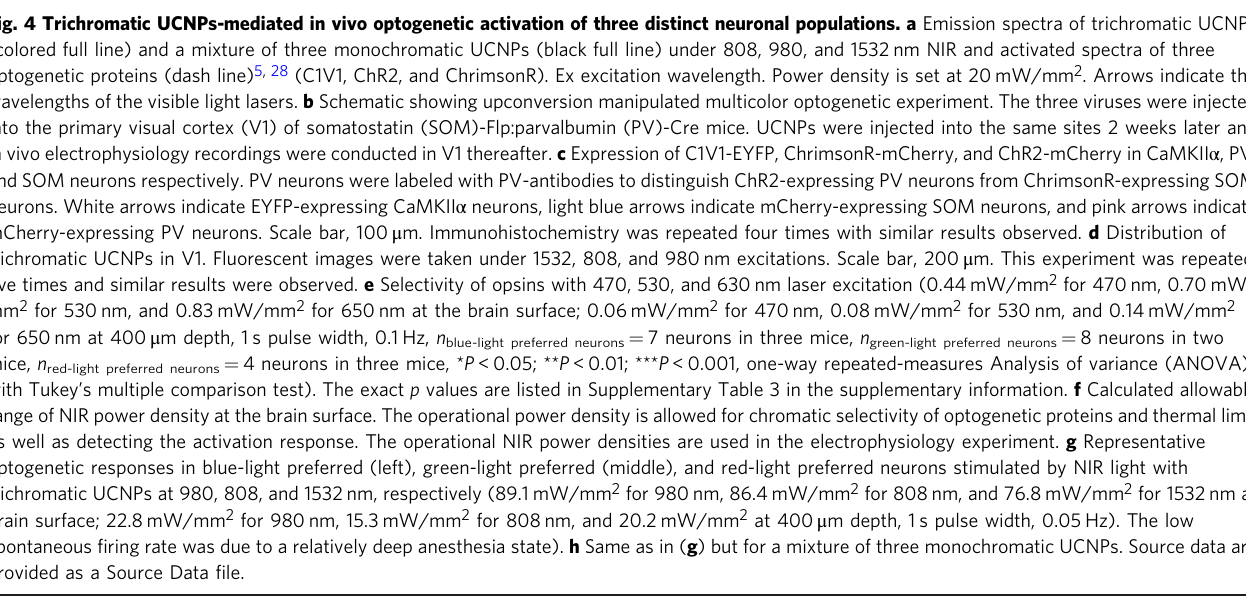
Fig. 4 Trichromatic UCNPs-mediated in vivo optogenetic activation of three distinct neuronal populations. a Emission spectra of trichromatic UCNPs (colored full line) and a mixture of three monochromatic UCNPs (black full line) under 808, 980, and 1532 nm NIR and activated spectra of three optogenetic proteins (dash line) 5, 28 (C1V1, ChR2, and ChrimsonR). Ex excitation wavelength. Power density is set at 20 mW/mm 2 . Arrows indicate the wavelengths of the visible light lasers. b Schematic showing upconversion manipulated multicolor optogenetic experiment. The three viruses were injected into the primary visual cortex (V1) of somatostatin (SOM)-Flp:parvalbumin (PV)-Cre mice. UCNPs were injected into the same sites 2 weeks later